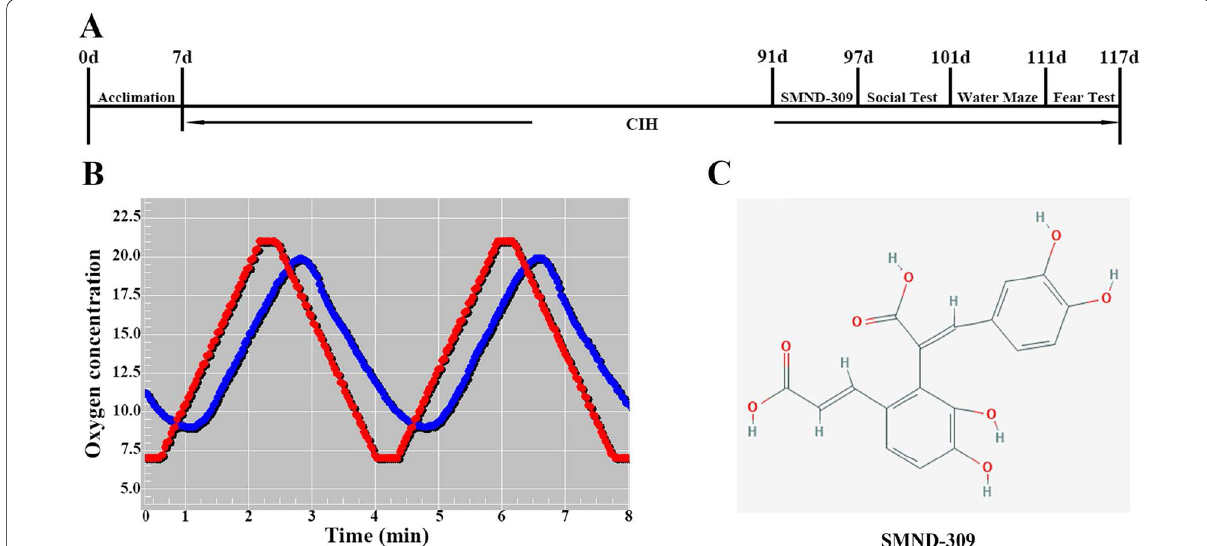
Fig. 1 The process of research and the structure of SMND-309. A The study workflow. After 7 days of acclimation, the mice were exposed to the CIH condition for about 3 months, and they were treated with SMND-309 at the last week. Behavioral tests were conducted as soon as CIH exposure finished. B The CIH treatment program. The red line represents the set point. The blue line represents the actual oxygen level. C The structure of